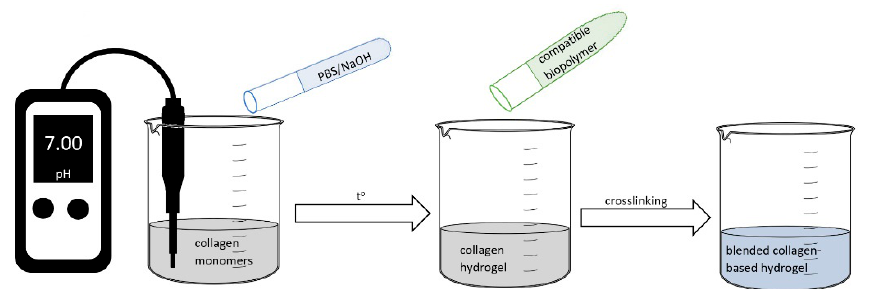
Figure 2. Graphical representation of traditional method for blended collagen-based hydrogels.